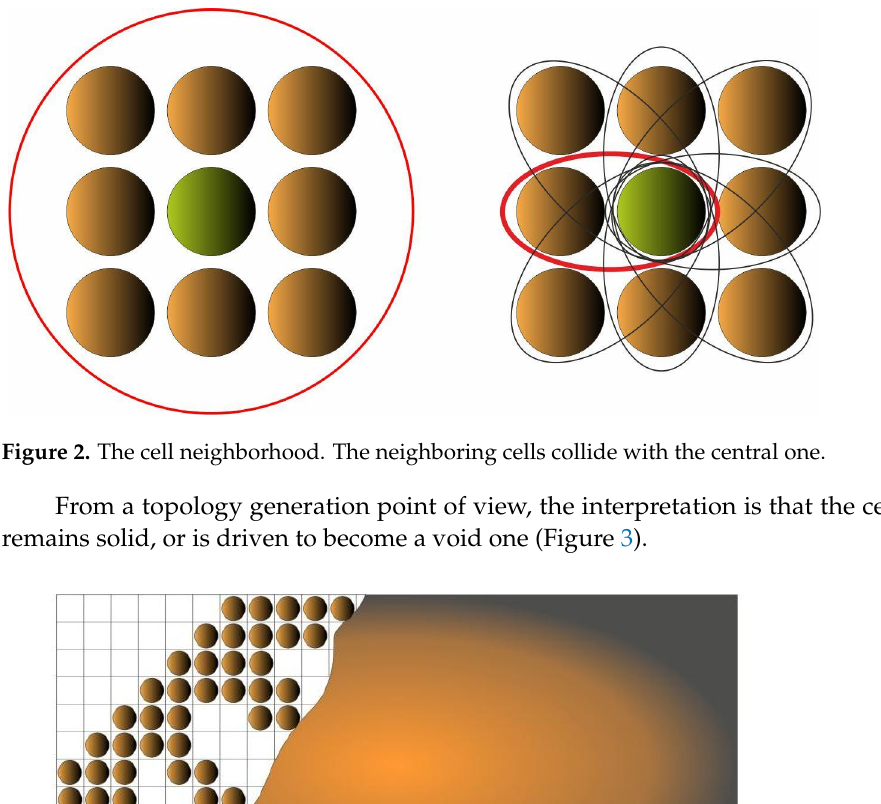
Figure 5. A neighboring body (k) collides with the central one (0). After collision. The governing equations are as follows: 𝑚 (cid:3038) 𝑣 (cid:3038)(cid:2869) (cid:3398) 𝑚 (cid:2868) 𝑣 (cid:2868)(cid:2869) = (cid:3398)𝑚 (cid:3038) 𝑣 (cid:3038)(cid:2870) (cid:3397) 𝑚 (cid:2868) 𝑣 (cid:2868)(cid:2870)